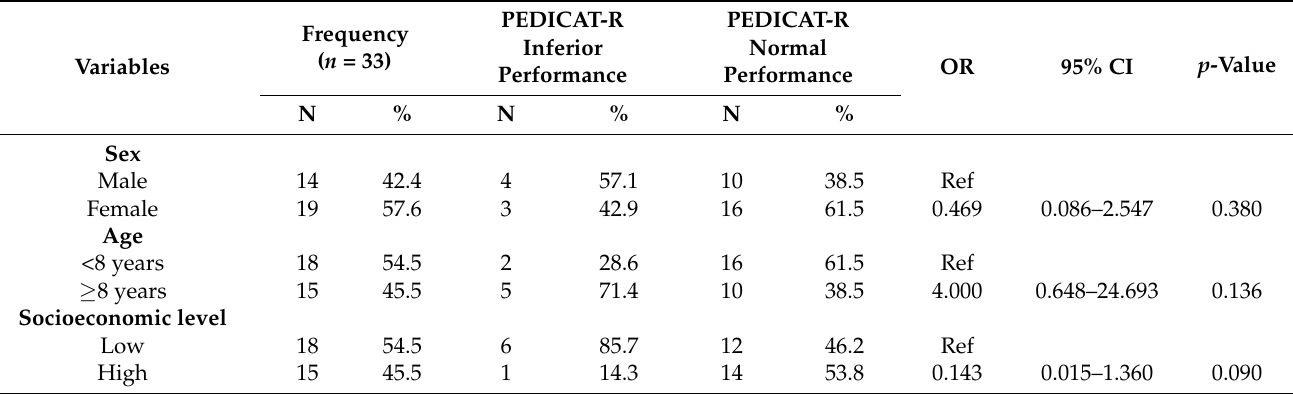
Table 4. Frequency, number of children with inferior and normal performance in PEDICAT- Responsibility, odds ratio, 95% confidence interval, and p